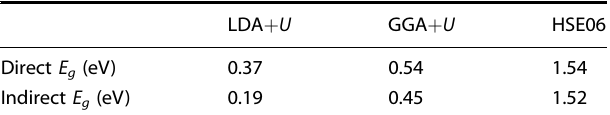
Table 2. The calculated direct and indirect energy gap E g values for the different exchange-correlation functionals with SOC